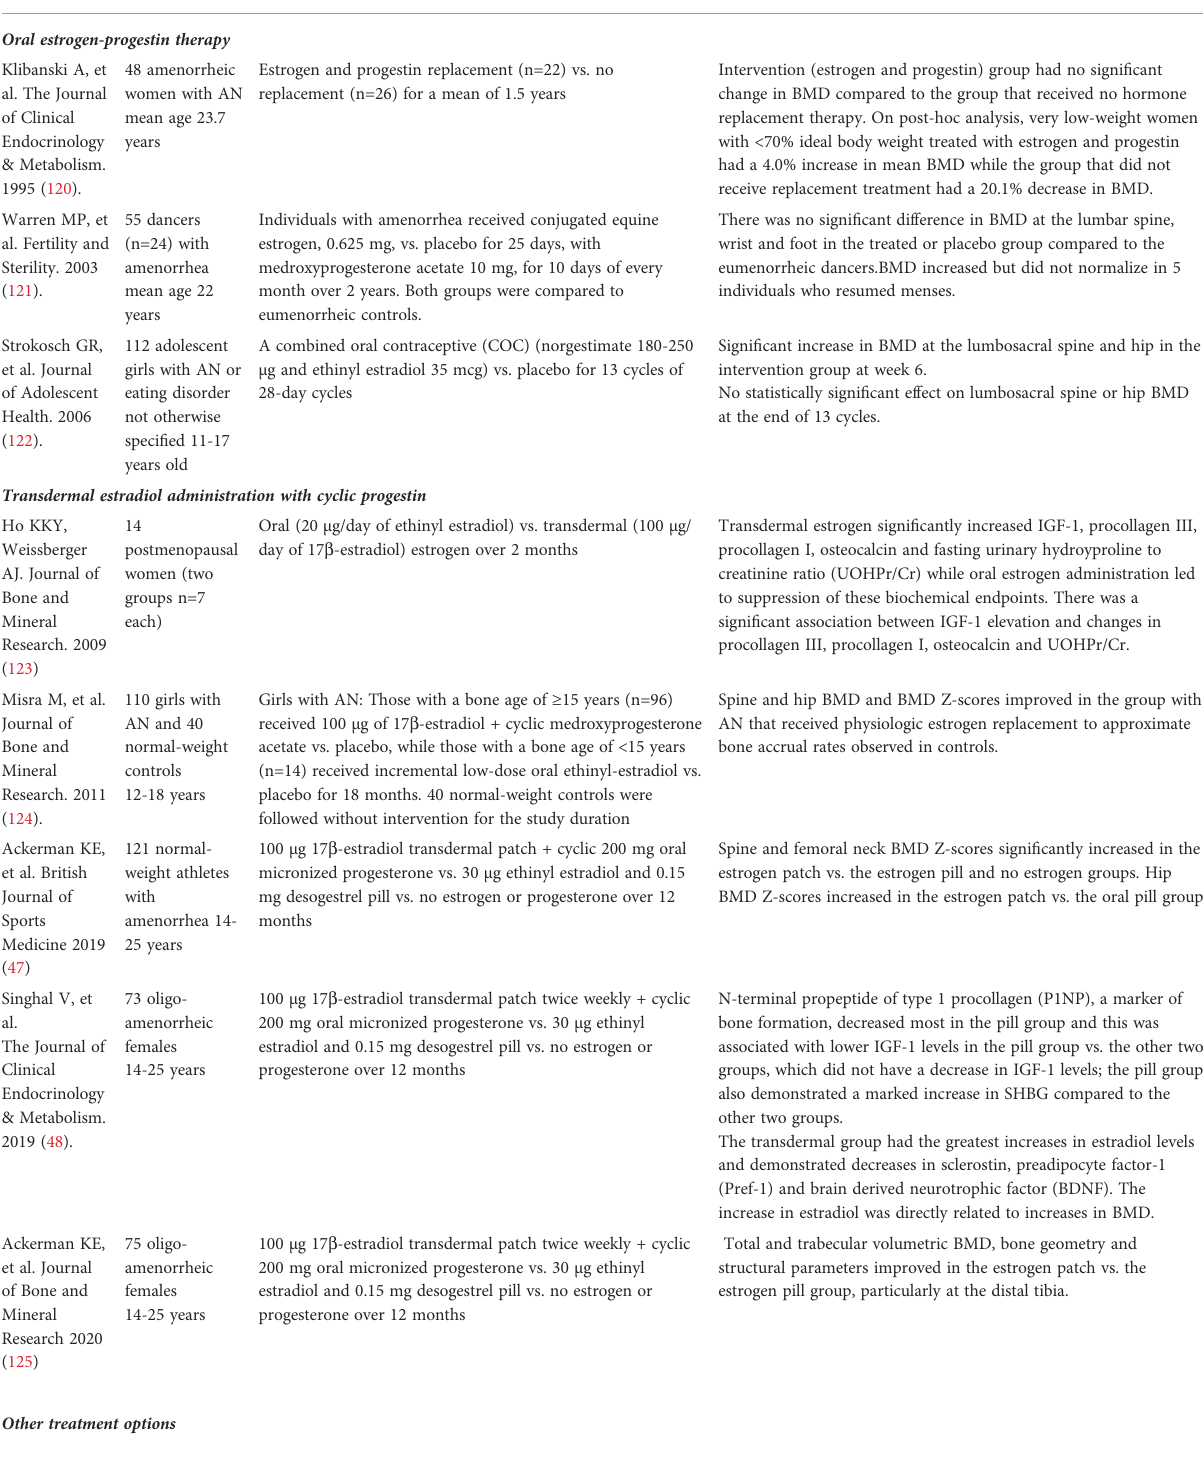
TABLE 1 Interventional studies in the management of functional hypothalamic amenorrhea. Study Population Intervention